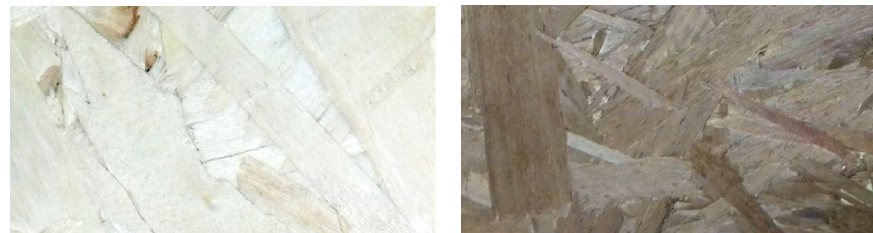
Figure 1. Appearance of poplar Oriented Strand Board (OSB) pre- ( left ) and post-thermal treatment ( right ).